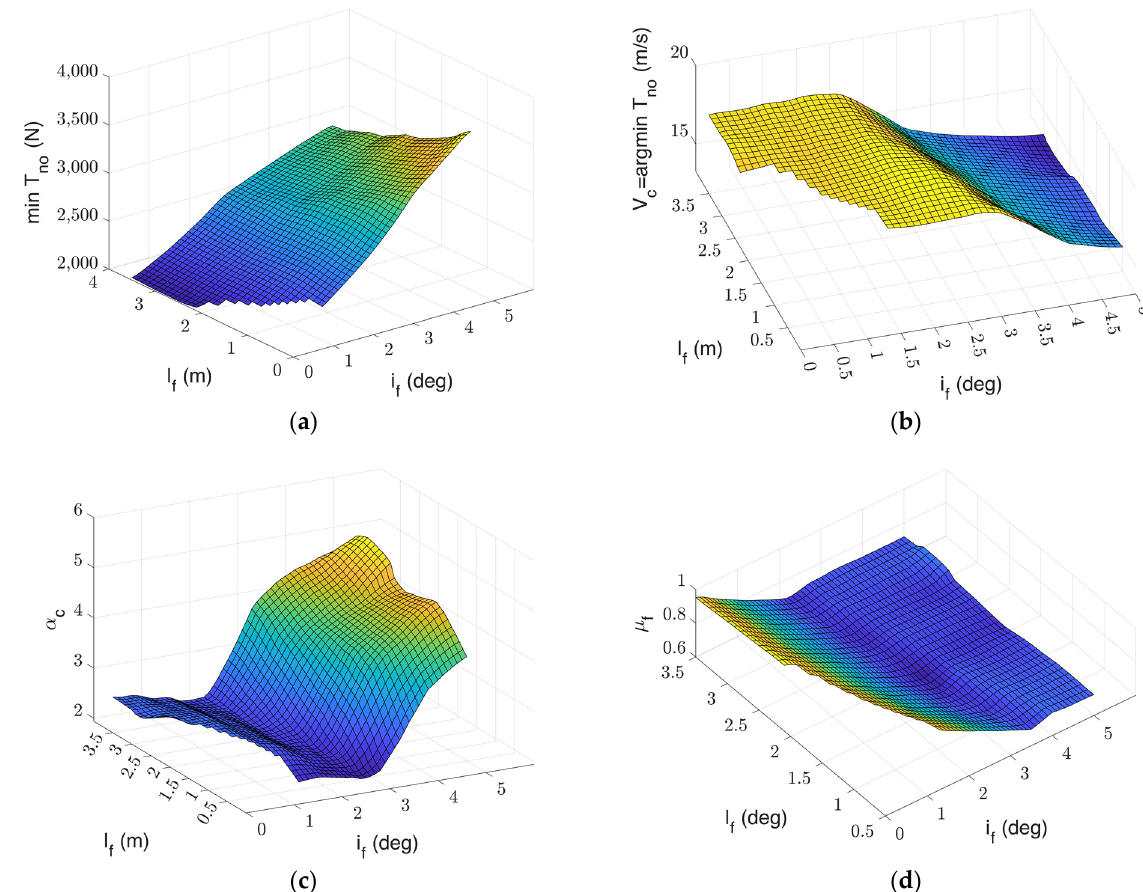
Figure 4. Main parameters of forward foil at cruise speed: ( a ) minimum thrust, ( b ) cruise speed at minimum thrust, ( c ) angle of attack, and ( d ) immersion coefficient.